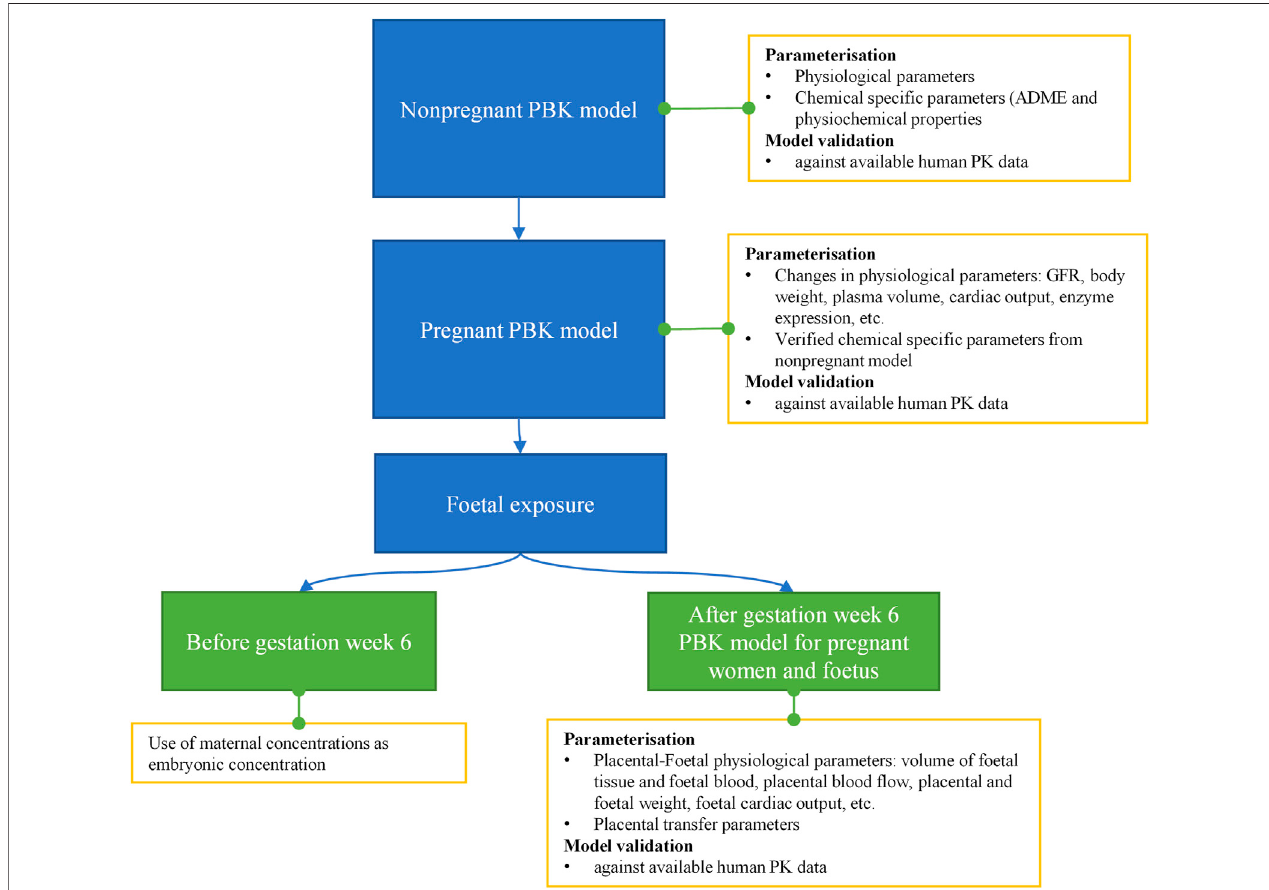
FIGURE 4 | Schematic diagram of the work fl ow of pregnant PBK model development for predicting foetal exposure.